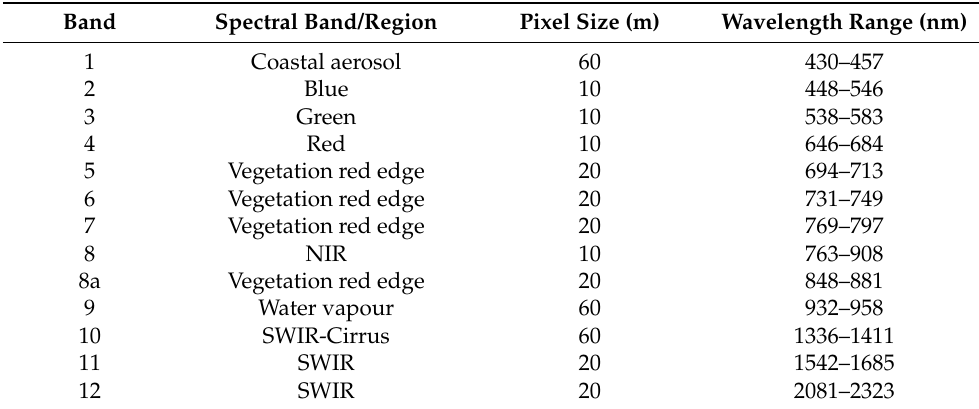
Table 2. Sentinel-2 band